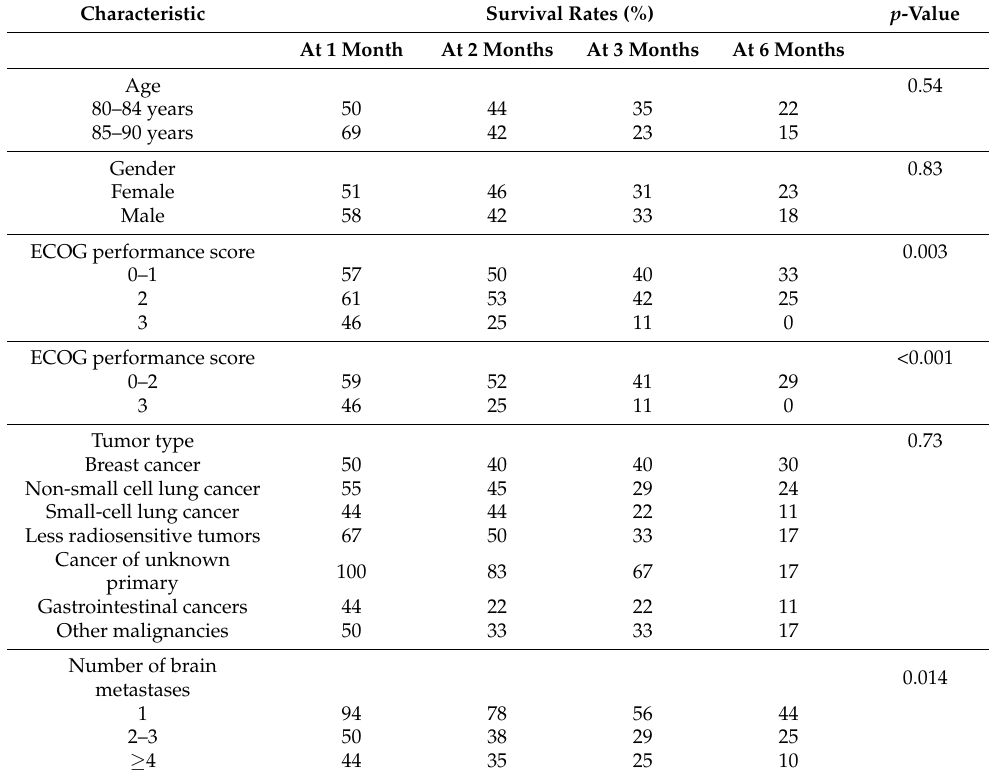
Table 2. Survival rates at 1, 2, 3, and 6 months following radiotherapy related to patient characteristics, treatment period, and dose-fractionation